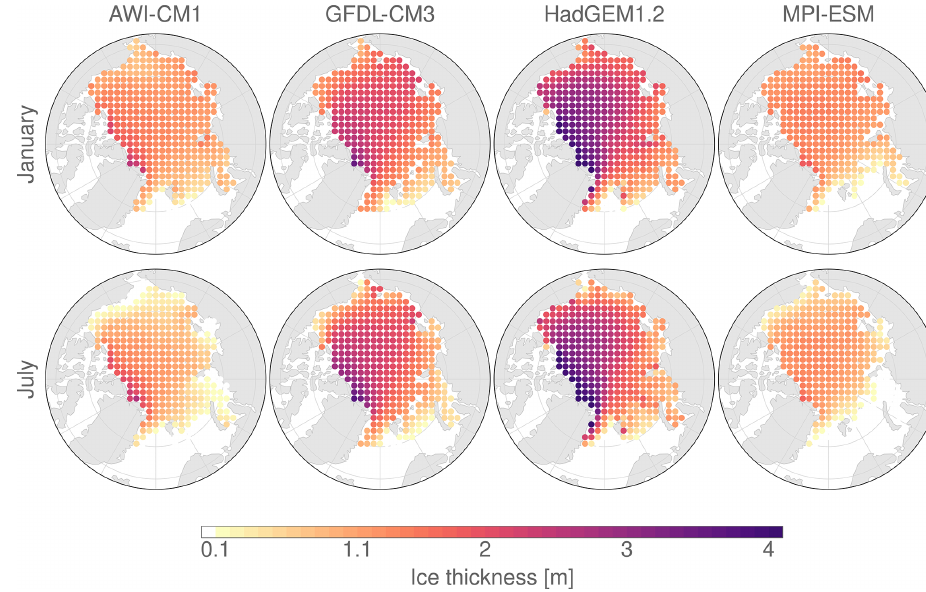
Figure B1. Climatological monthly mean sea ice thickness for January (top) and July (bottom), derived from the control run.